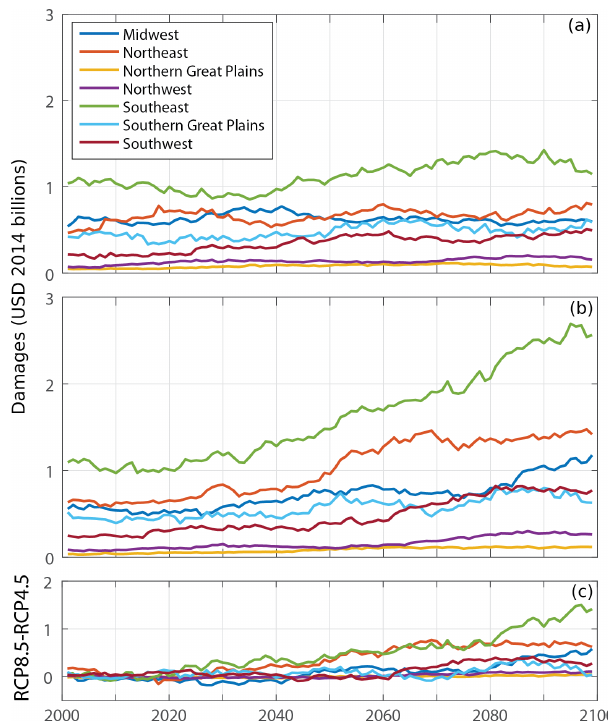
Figure 8. Average annual flooding damages by region for (a) RCP 4.5 and (b) RCP 8.5. (c) Difference in annual flood damages be- tween RCP 4.5 and RCP 8.5 by region (billions of 2014 US dollars). See Fig. 4 for delineation of